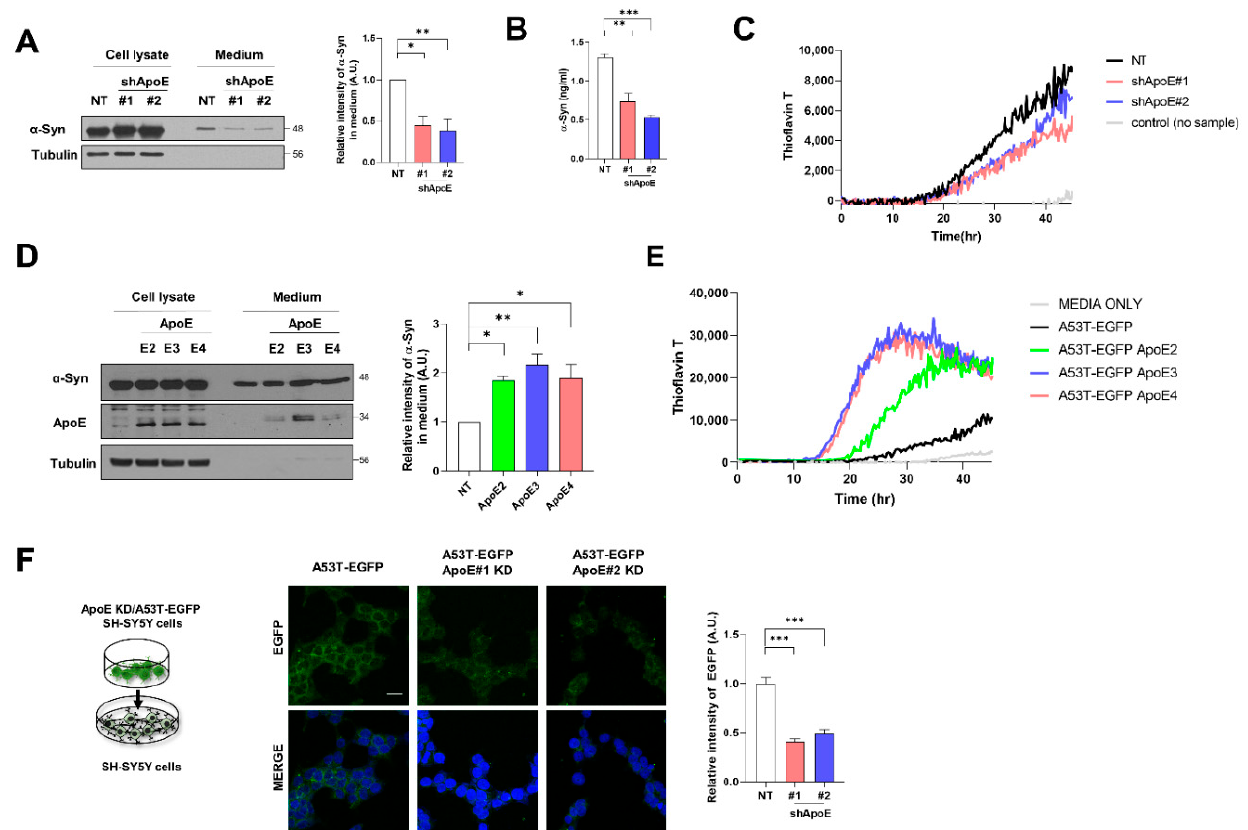
Figure 5. ApoE deficiency inhibits α -syn release in SH-SY5Y cells. ( A ) Differentiated NT and ApoE KD #1, #2/A53T α -syn-EGFP OE SH-SY5Y cells were cultured in serum-free media for 1 day, and